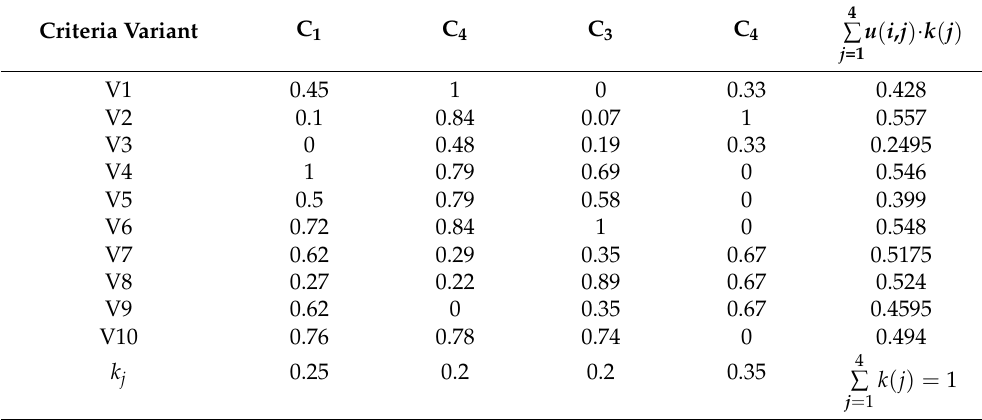
Table 5. Utility and decision matrix for training cells and, if necessary, conversion to serial assembly cell.